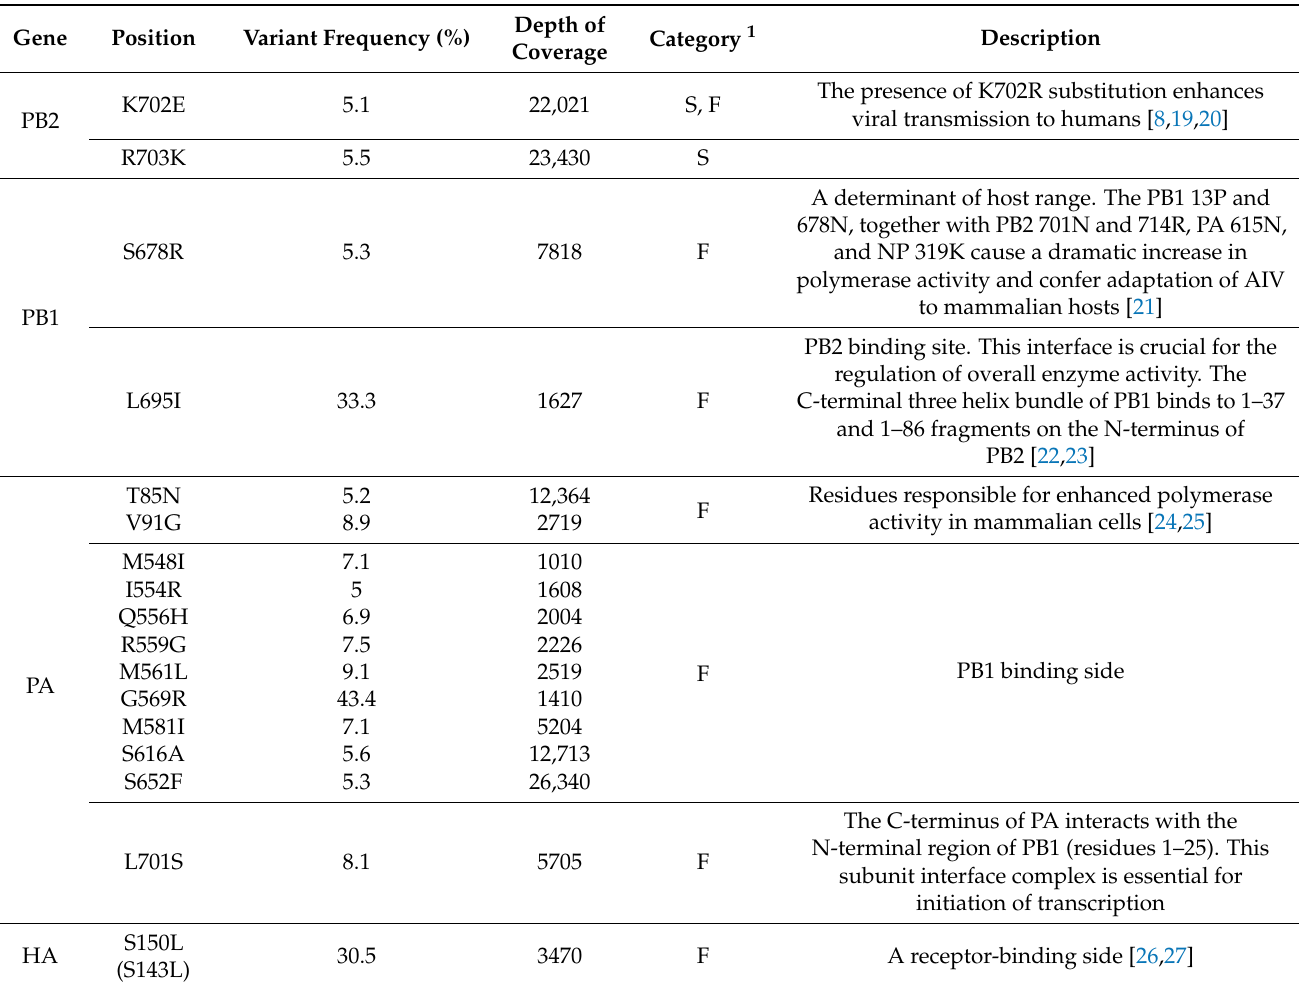
Table 2. Molecular changes in the A/duck/AL/2017 (H7N9) LPAIV viral genome assembled from RNA extracts recovered from contact chickens at day 4 and day 6 post exposure from cloacal swab samples. Contact chickens were transferred into directly challenged chickens at 24 h post challenge. The frequencies of variants were computed using a minimum sequence coverage of 500 reads covering the base and a minimum variant frequency of 5%. The maximum p -value of 10 − 6 and a minimum strand-bias p -value of 10 − 5 when exceeding a 65% bias were used to call the variants with an average quality >